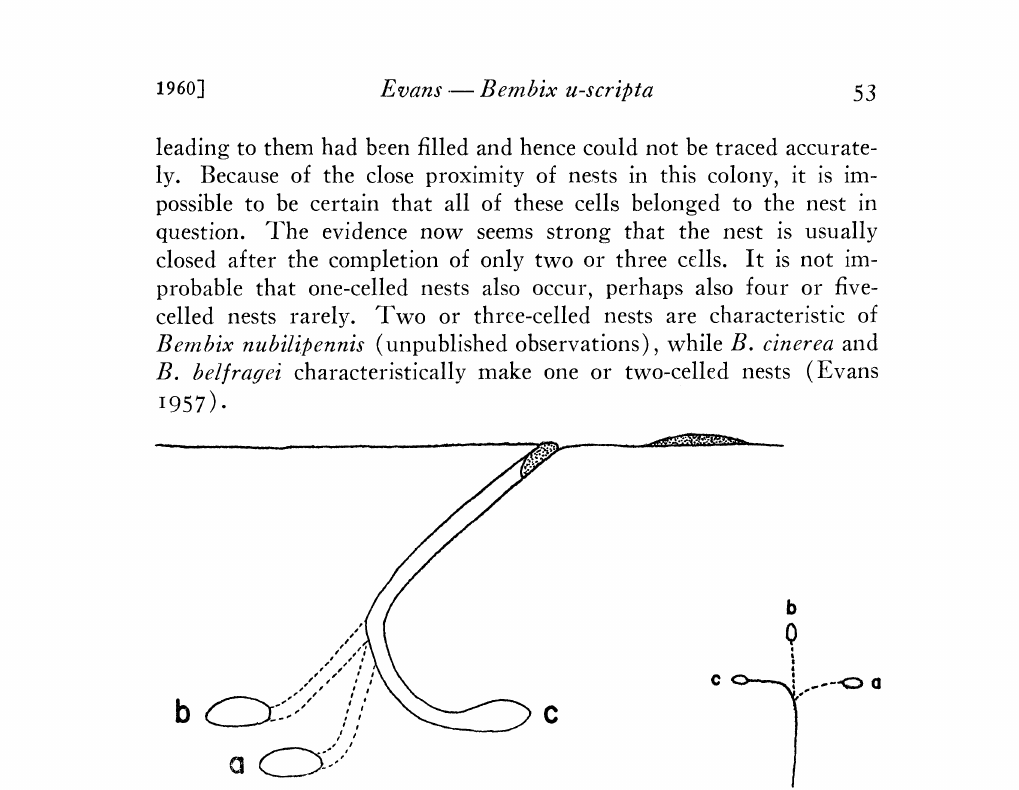
Fig. 2.--Typical three-celled nest of Bembix u-scripta (our field note no. 1635, Rodeo, N. Mex.). Cell a contained a cornpleted and hardened cocoon, so was obviously the first cell of the nest. Cell b contained a fresh, still soft cocoon; cell c was a new cell which was empty when the nest was dug out. The figure on the left shows the nest in lateral view, compressed to a single plane, while the sketch on the right shows the proper relationship of the cells in a horizontal